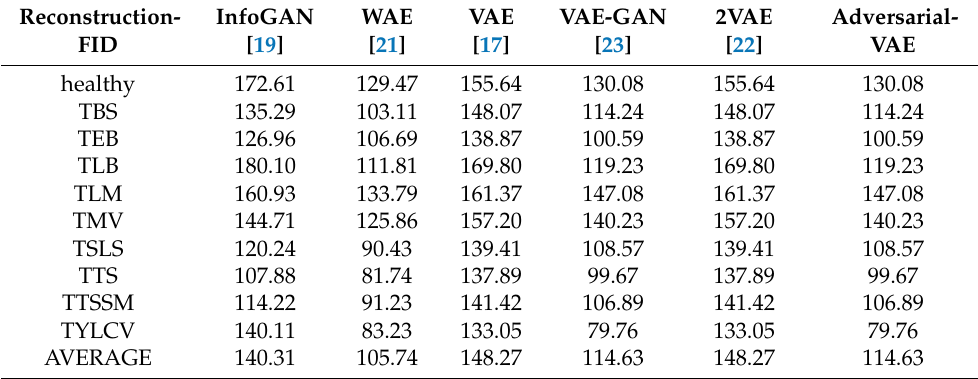
Table 5. Reconstruction-FID comparison between different generative